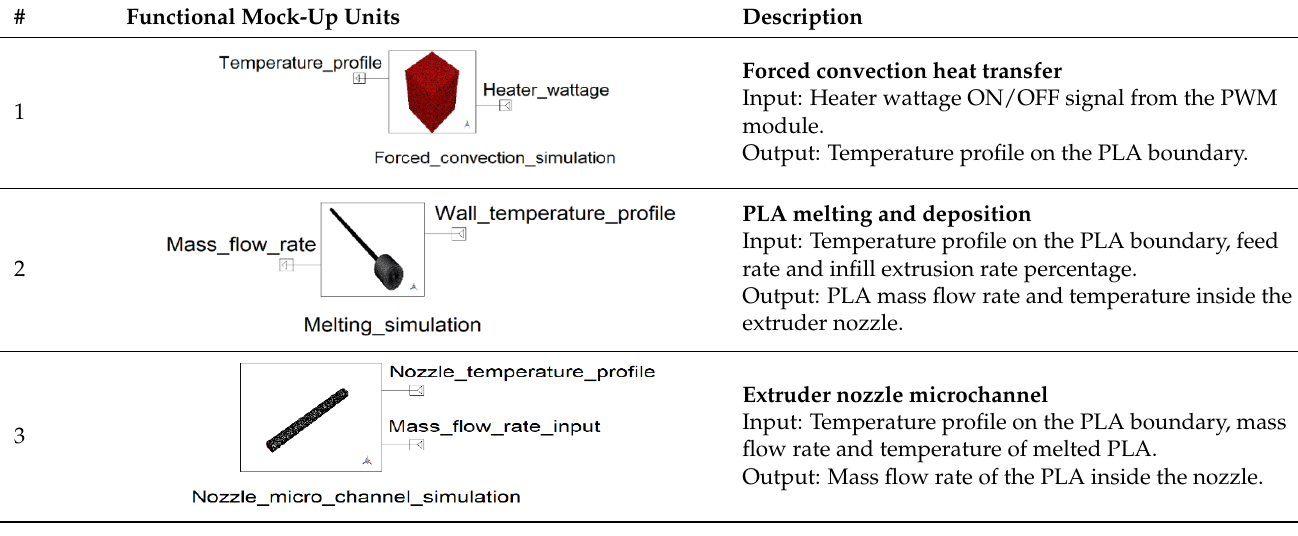
Table 2. Inputs and outputs for the functional mock ‐ up units.